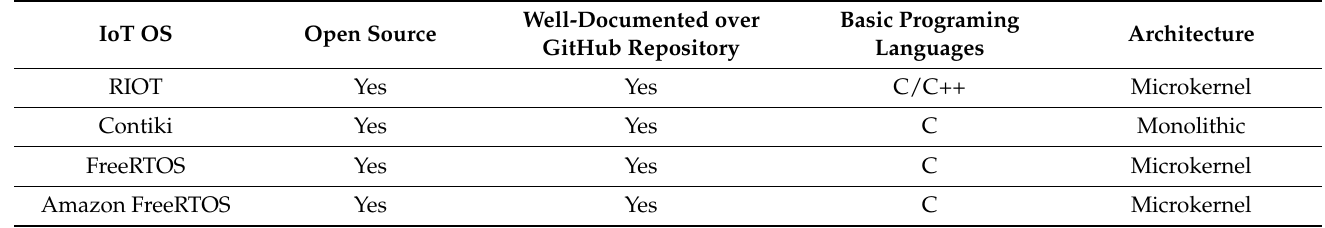
Table 1. Overview of the case study of low-end IoT